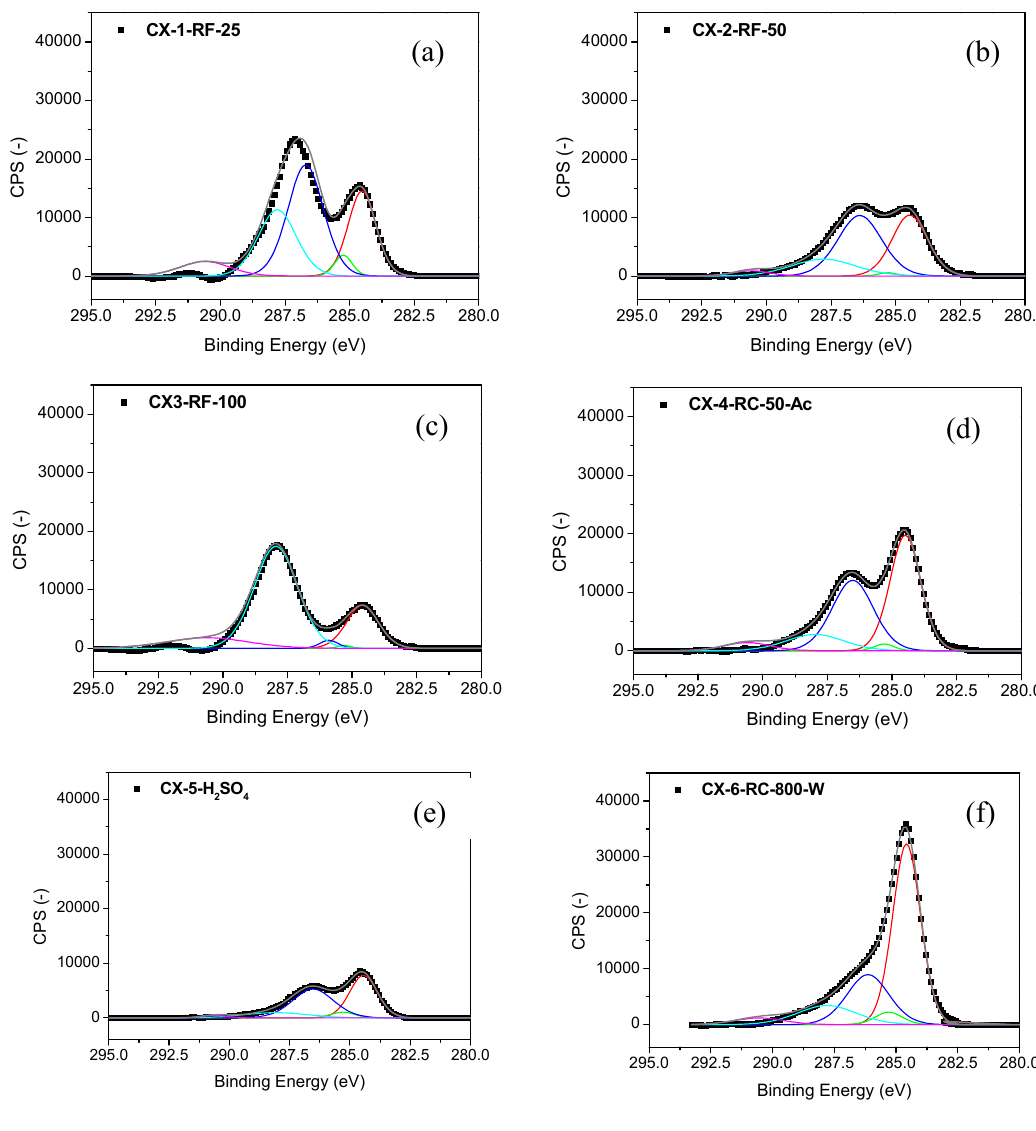
295.0 292.5 290.0 287.5 285.0